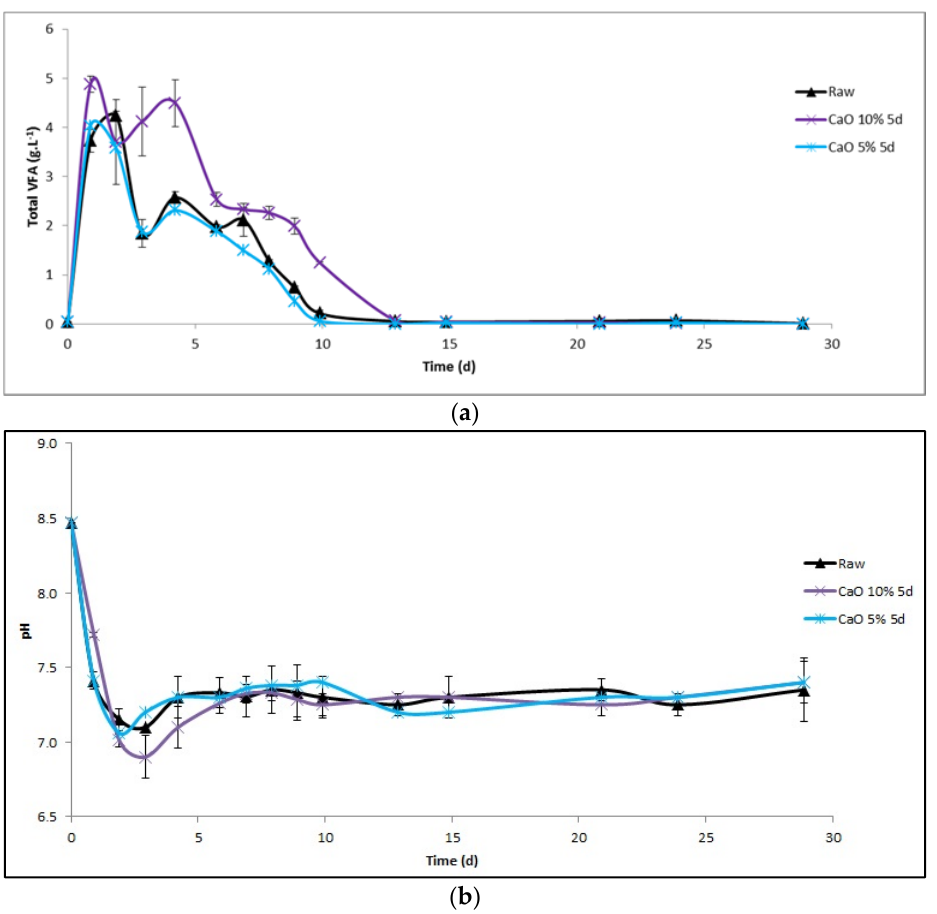
Figure 4. Volatile fatty acid (VFA) concentration ( a ) and pH variation ( b ) in leachate during the first 30 days. Table 3. VFA/alkalinity ratio at 3 days, methane production at 6, 10, 15, 24, 29, and 59 days, expected methane production calculated from BMP values, and first-order kinetics